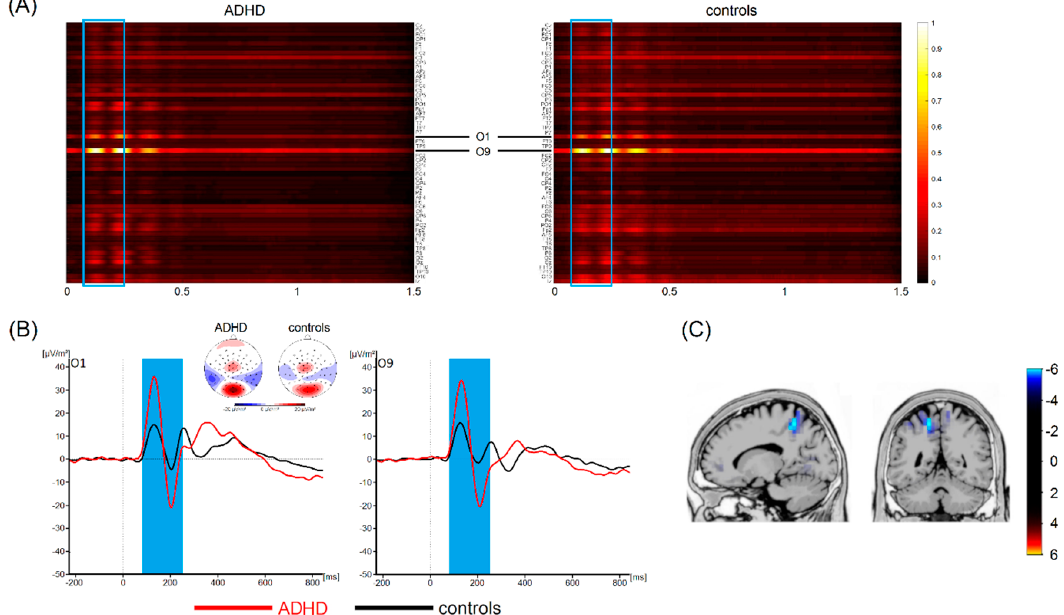
Figure 4. ( A ) Visualization maps showing the relevance of all time points and electrodes for classification between patients with ADHD and healthy controls. Values close to 1 indicate that the specific feature at the specific time points contributes most to the classification accuracy. The blue frame highlights the most important time range. Based on visual inspection, electrodes O1 and O9 carried the highest relevance. ( B ) Corresponding waveforms (event-related potentials) at the most relevant electrodes are shown with the relevant time range according to the applied machine learning